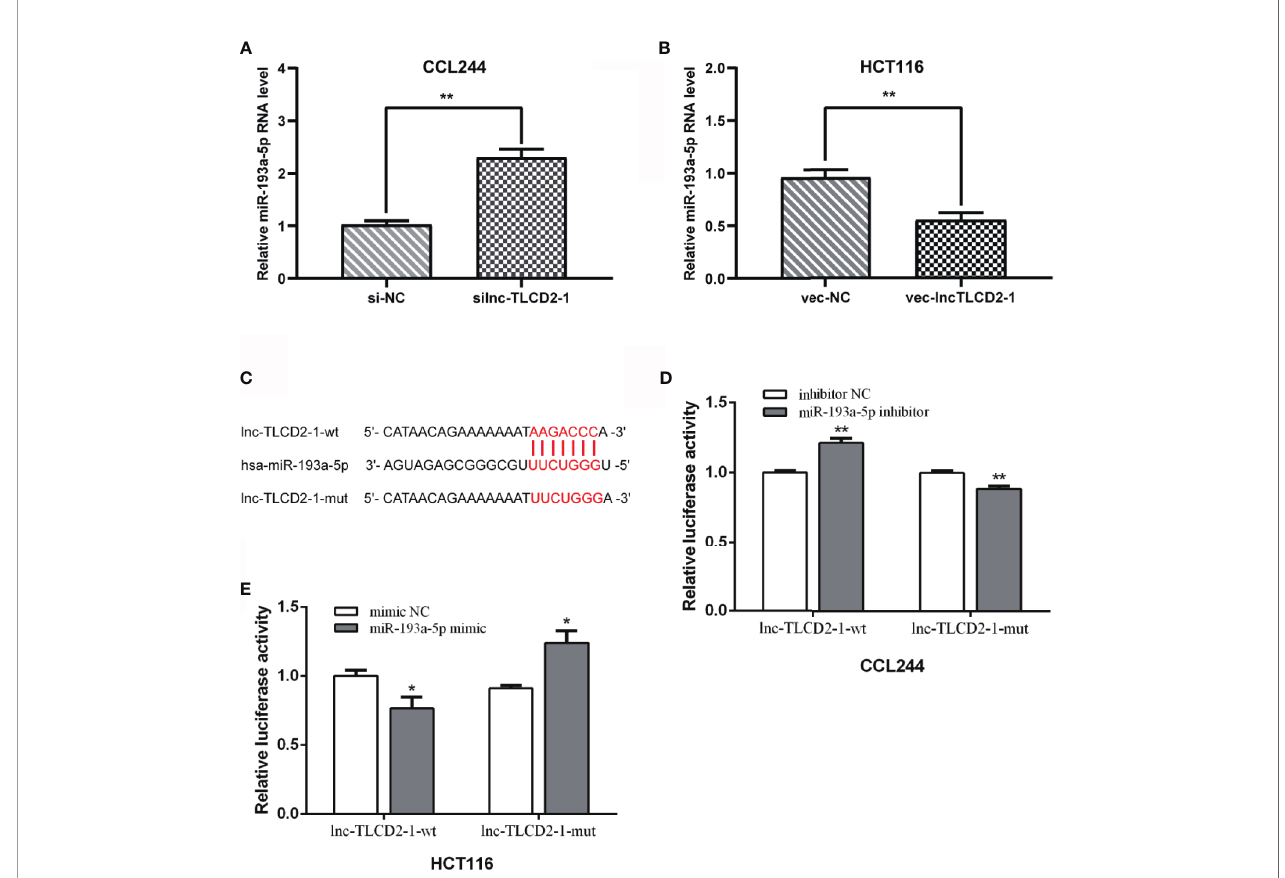
FIGURE 4 | Lnc-TLCD2-1 is a sponge of miR-193a-5p in CRC. (A) The expression of miR-193a-5p was increased after CCL244 transfection with silnc-TLCD2-1. (B) The expression of miR-193a-5p was decreased after HCT116 transfection with veclnc-TLCD2-1. (C) Binding sites of lnc-TLCD2-1 and miR-193a-5p predicted by Starbase, the mutant sites we constructed were demonstrated. (D) MiR-193a-5p inhibitor obviously improved the dual luciferase activity of the lnc-TLCD2-1-wt reporter but not lnc-TLCD2-1-mut reporter in CCL244. (E) MiR-193a-5p mimic signi fi cantly reduced the dual luciferase activity of the lnc-TLCD2-1-wt reporter but not lnc-TLCD2-1-mut reporter in HCT116. (P<=0.05 means statistically signi fi cant, *p < 0.05, **p <